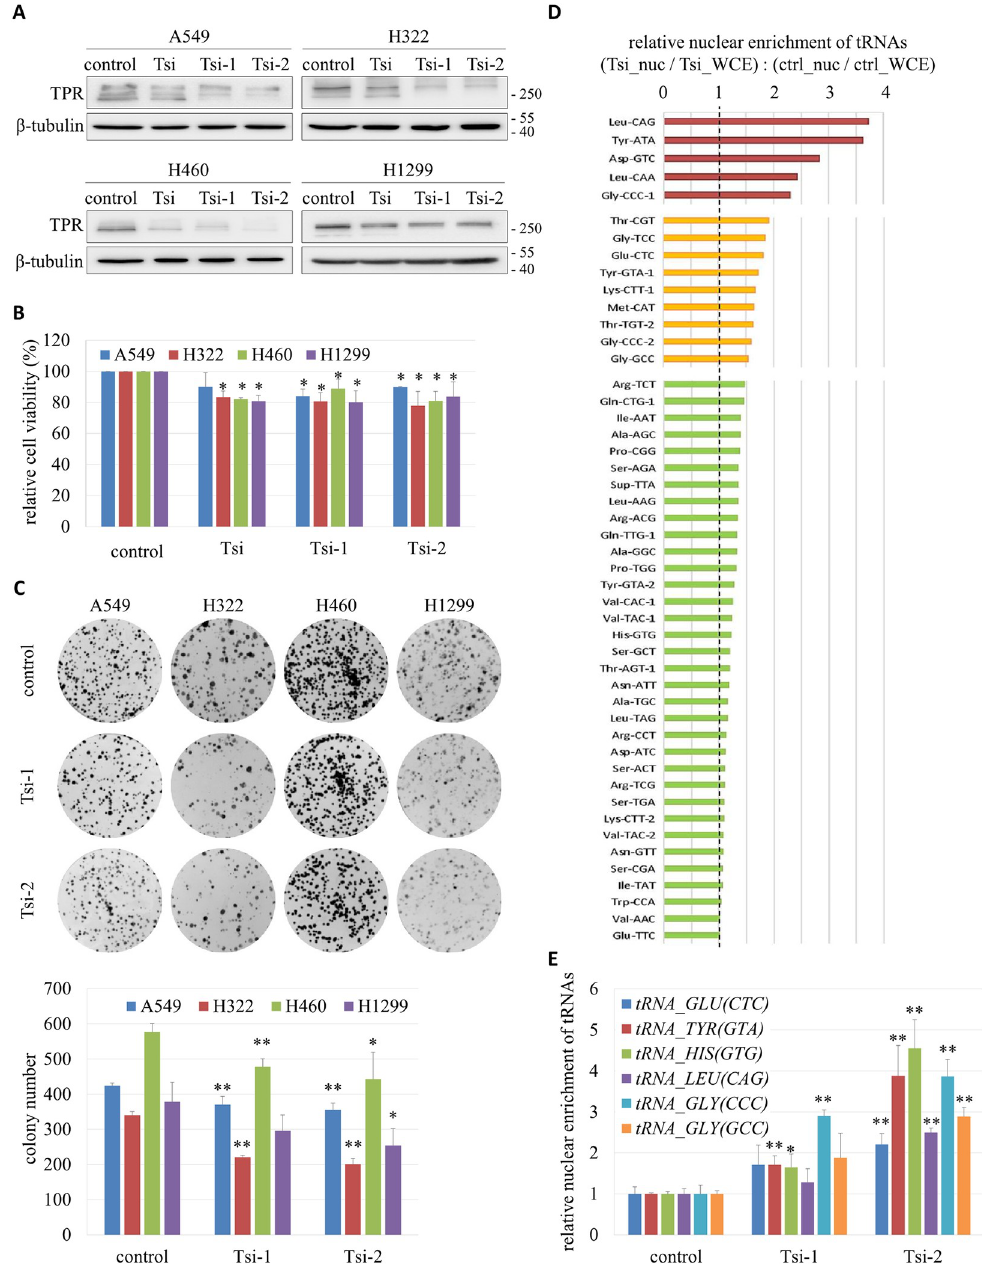
Fig 4. Growth inhibition and nuclear accumulation of tRNAs in lung cancer cells with TPR knockdown. (A) Western blot of TPR in A549, H322, H460 and H1299 cells transfected with TPR-specific siRNAs (Tsi, Tsi-1 and Tsi-2) or a control siRNA. (B) Cell viability measured by MTS assay. Data (mean ± SD, n = 3) were analyzed by paired Student’s t -test; � P < 0.05. (C) Cell proliferation capacity evaluated by colony formation assay. Representative images were shown on the top panel. Quantification was presented on the bottom panel. Data (mean ± SD, n = 3) were analyzed by paired Student’s t - test; � P < 0.05, �� P < 0.01. (D) Nuclear enrichment of tRNAs in TPR knockdown cells relative to control cells. The nrStar Human tRNA PCR Array was used to measure the levels of nuclear-encoded tRNAs and U6 small nuclear RNA included in the array in the nuclear (ctrl_nuc) and whole cell extracts of A549 cells (ctrl_WCE), as well as A549 cells after TPR knockdown (Tsi_nuc and Tsi_WCE, respectively). The values of the tRNAs were normalized to that of U6, which was known to remain in the nucleus after transcription by RNA polymerase III. Nuclear enrichment of each tRNA in Tsi cells relative to control cells was reported as the ratio of (Tsi_nuc/Tsi_WCE): (ctrl_nuc/ctrl_WCE), as shown in the graph. (E) Direct measurement of nuclear tRNA enrichment by RT-qPCR. Nuclear and whole cell RNA extracts were prepared from A549 cells (control) and A549 cells with TPR knockdown (Tsi-1 and Tsi-2). RT-qPCR was performed for each extract